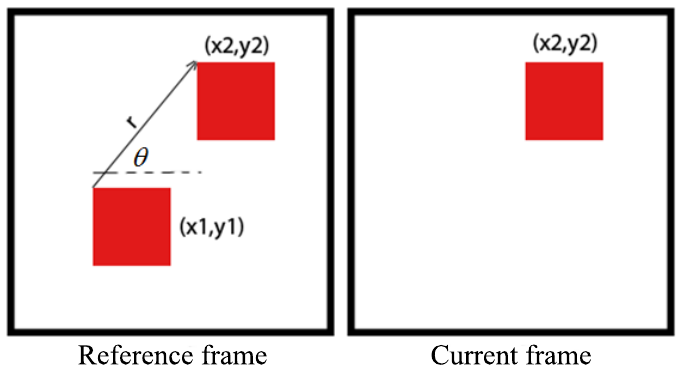
Figure 3. Motion vector construction.